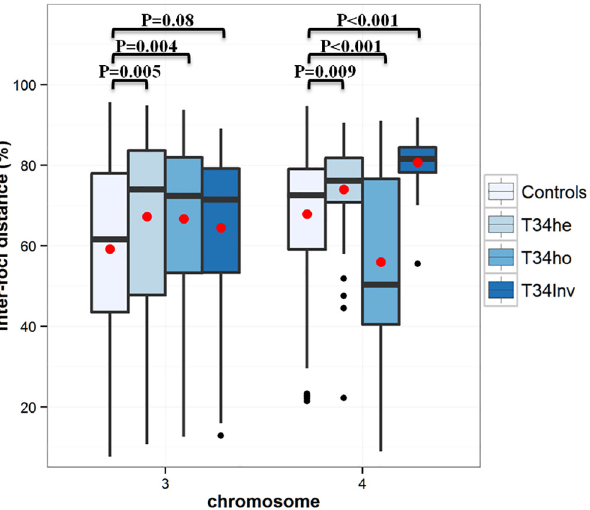
Fig 3. Box-plot diagrams showing the inter-foci distances (in % SC) measured for chromosomes 3 and 4 in the different boars. The black horizontal bars and the red points represent the median and the mean values,